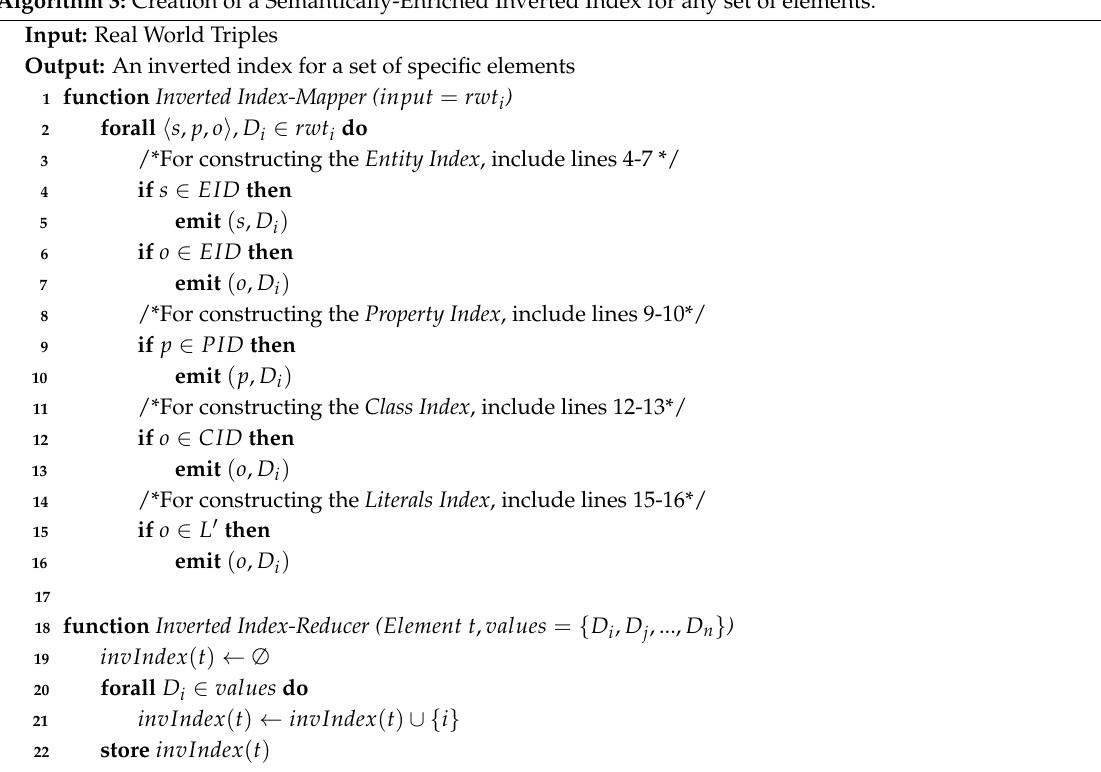
Algorithm 3: Creation of a Semantically-Enriched Inverted Index for any set of